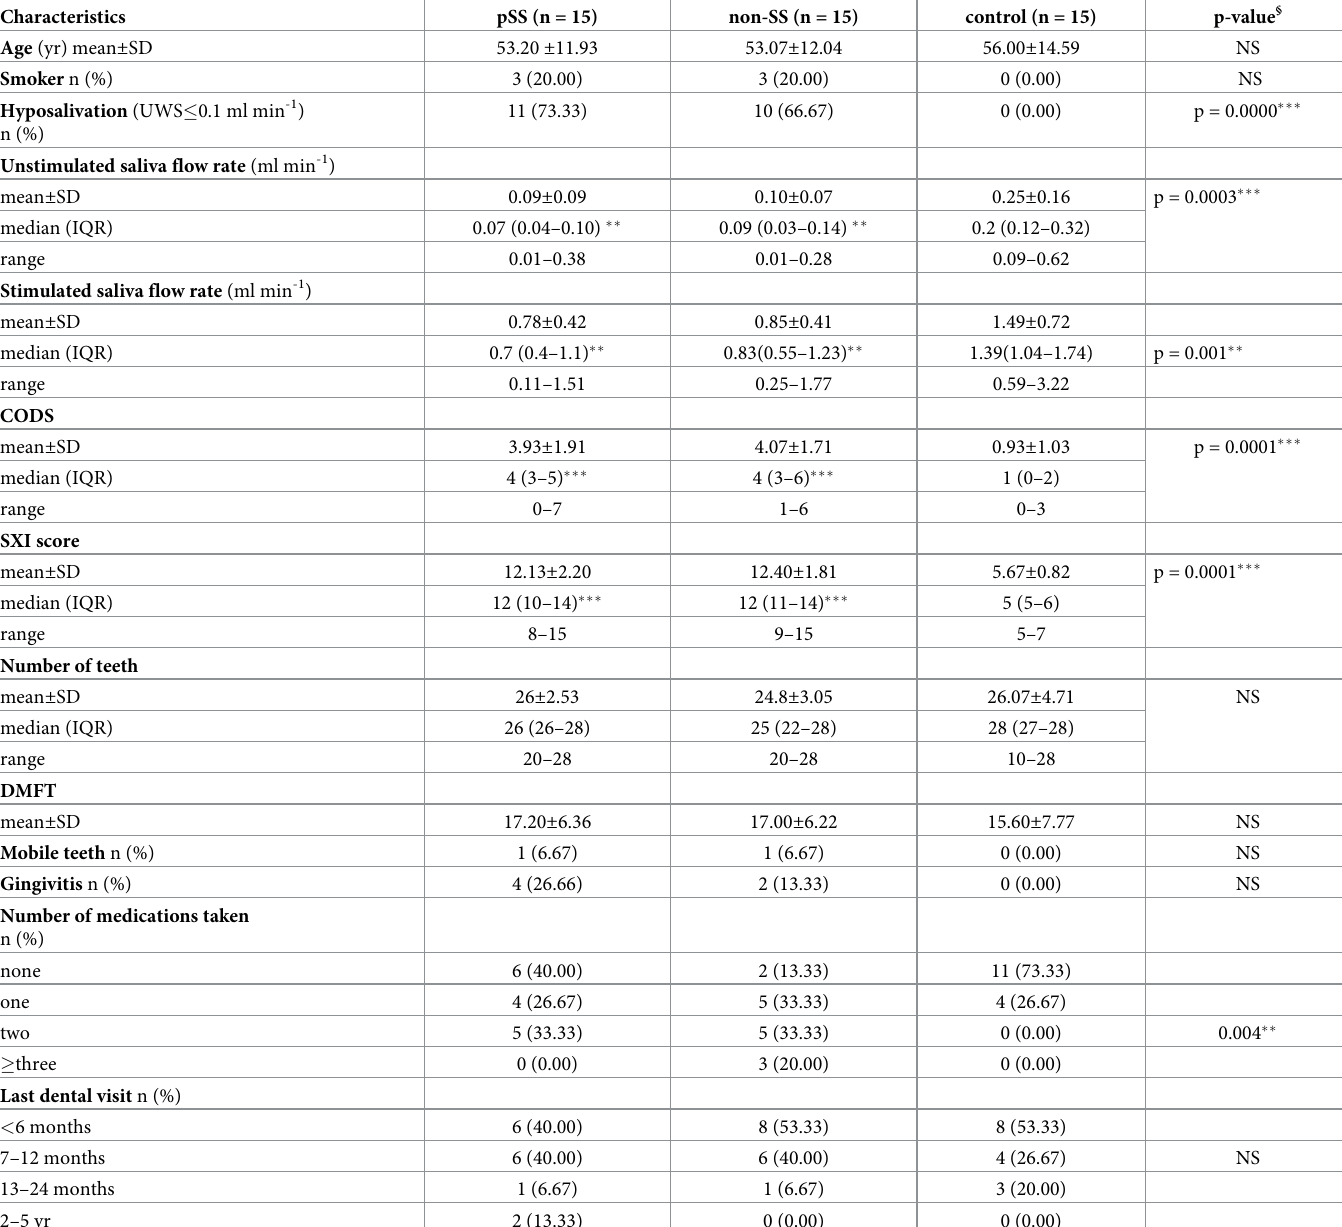
Table 1. Characteristics of the three participant